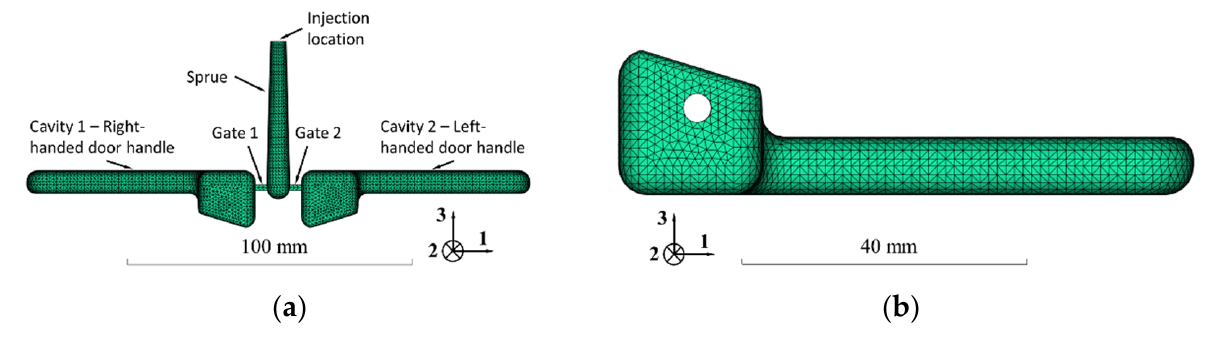
Figure 3. The simulation model for Moldflow Insight 2011 ( a ) and for Abaqus ( b ). The results for the material model, including the fibre orientation and residual stress, were exported and then imported into Abaqus 6.11 software (V é lizy-Villacoublay,